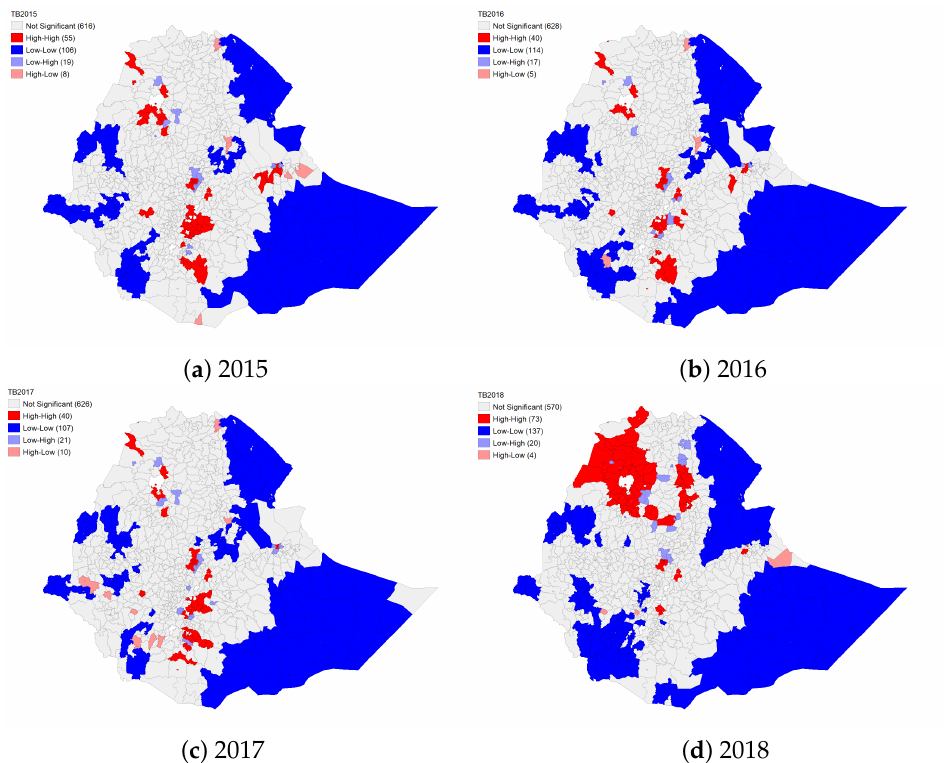
Figure 1. Spatial clusters and spatial outliers of tuberculosis notification in Ethiopia at district level from 2015 to 2018 using the local Moran’s I